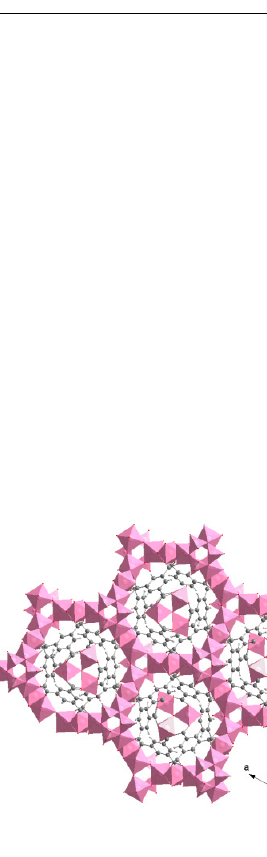
Figure 1. Schematic representation of the MIL-96(Al), MIL-100(Al) and MIL-110(Al) crystal structures (from left to the right). AlO 6 octahedra (magenta), C atoms (grey) and O atoms (red). Structures are drawn from the CIF-files by using DIAMOND program [46]. MIL-96(Al) and MIL-100(Al) both comprise tri-nuclear Al-oxo clusters and MIL-96(Al) additional sinusoidal chains of aluminium octahedra. MIL-110(Al) exhibits unique octanuclear Al-oxo clusters.